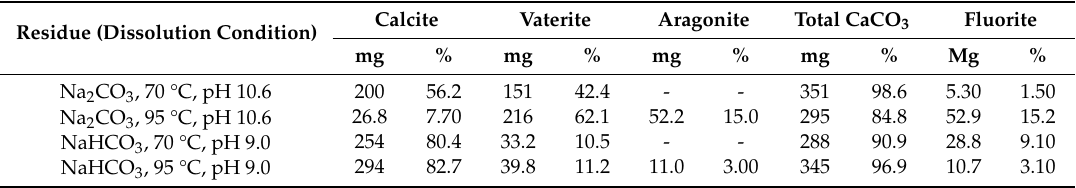
Table 2. Amount of present minerals based on residue analysis by XRD-Rietveld refinement and calculated considering total amount of residue generated.